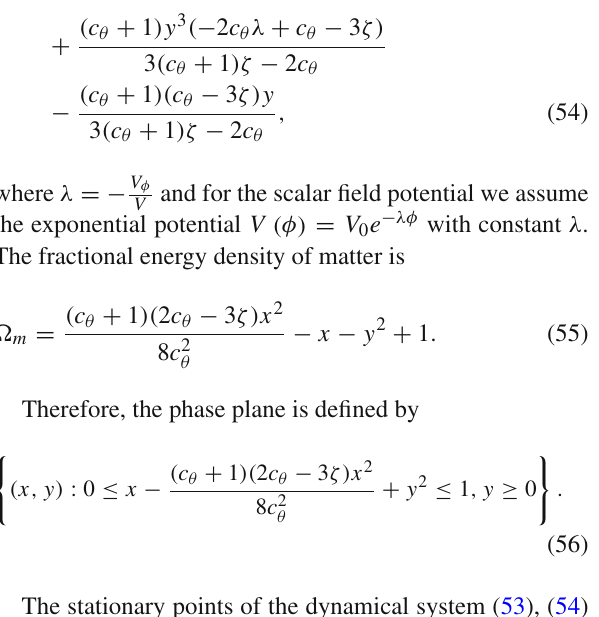
Fig. 5 Region plots in the space of parameters { c θ ,ζ } , where the sta- tionary point x 1 describes and accelerated universe when λ = 2, that is